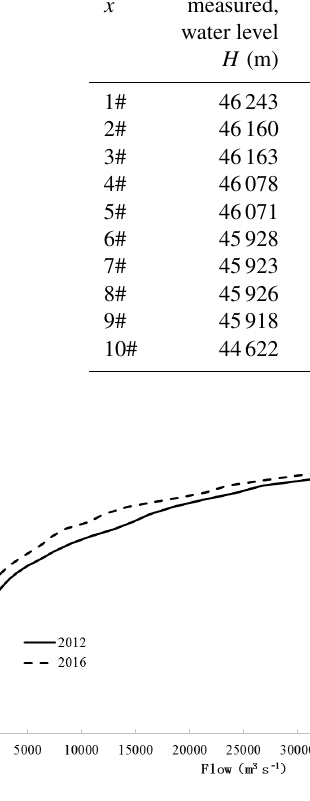
Figure 5. Impact of construction work in 2016 on the stage- discharge relationship at the Road No. 2 road bridge over of the Hanjiang River in Zhongxiang.